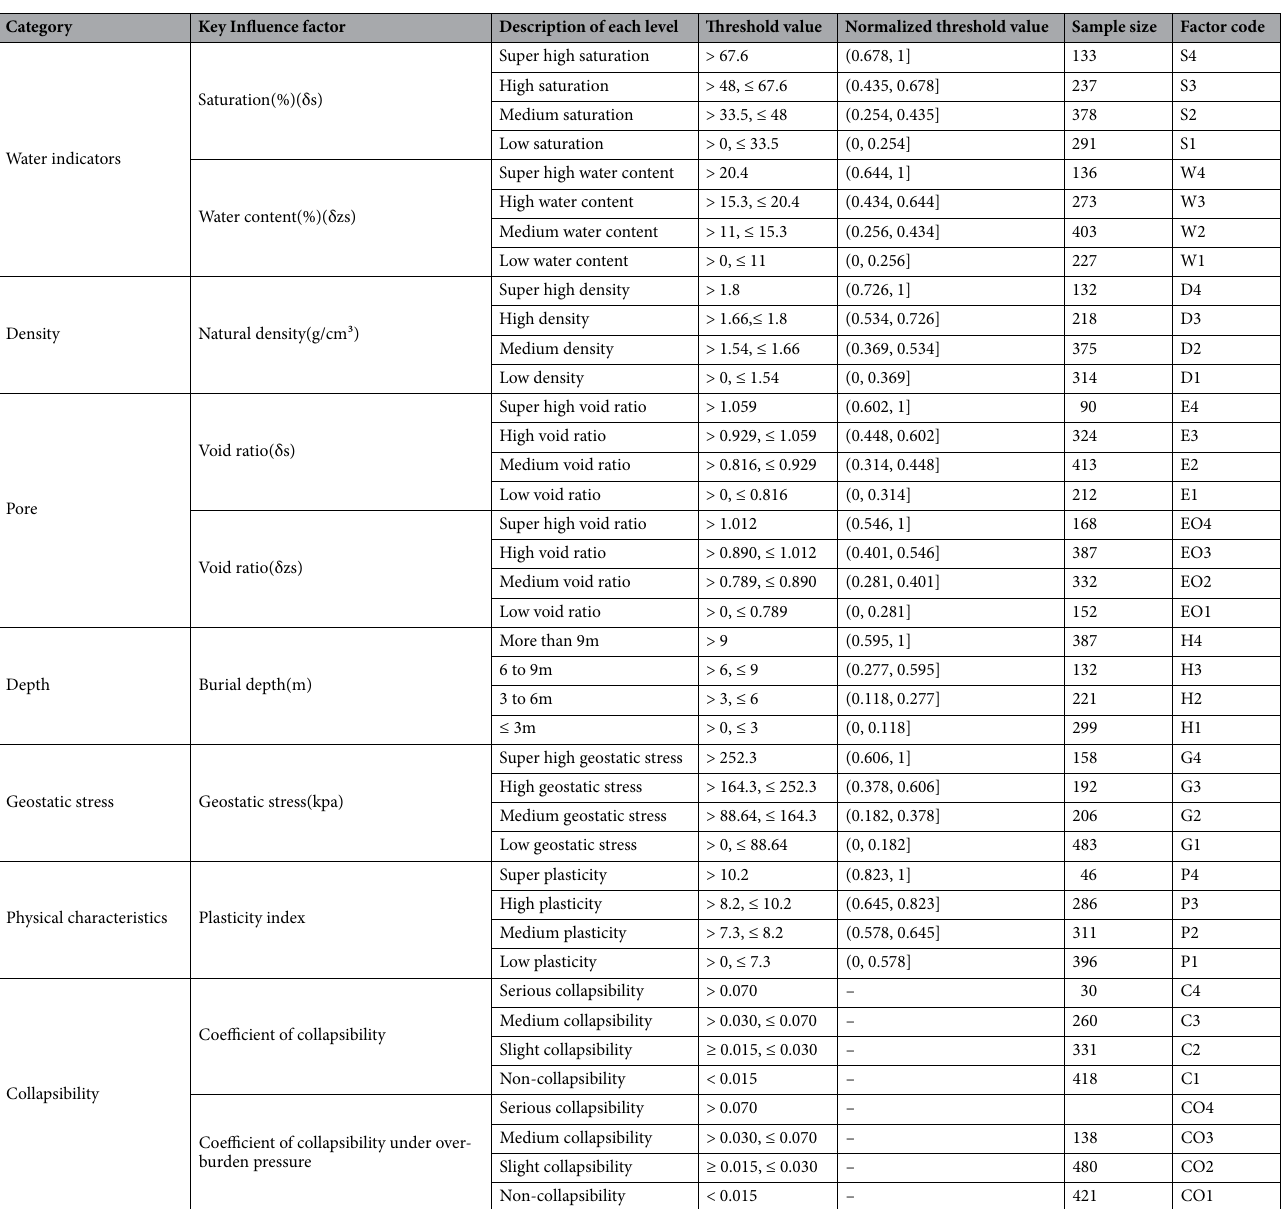
Table 2. Classification standards for collapsibility and key influence